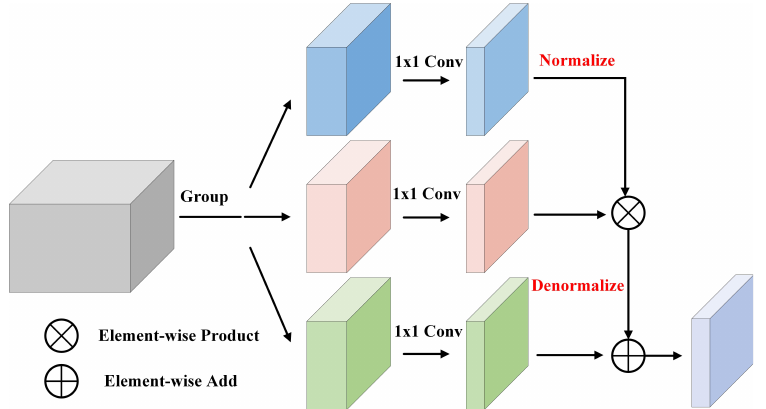
Figure 3. The structure design of DFC. Best viewed in